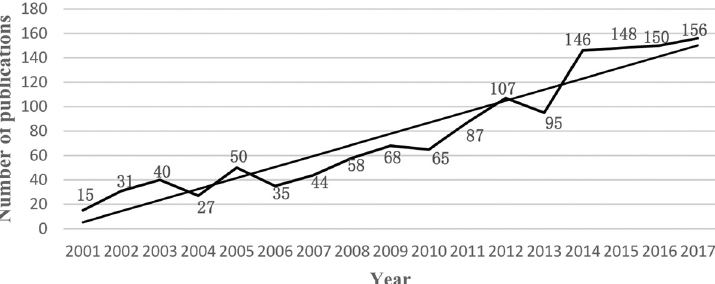
Figure 1. Number